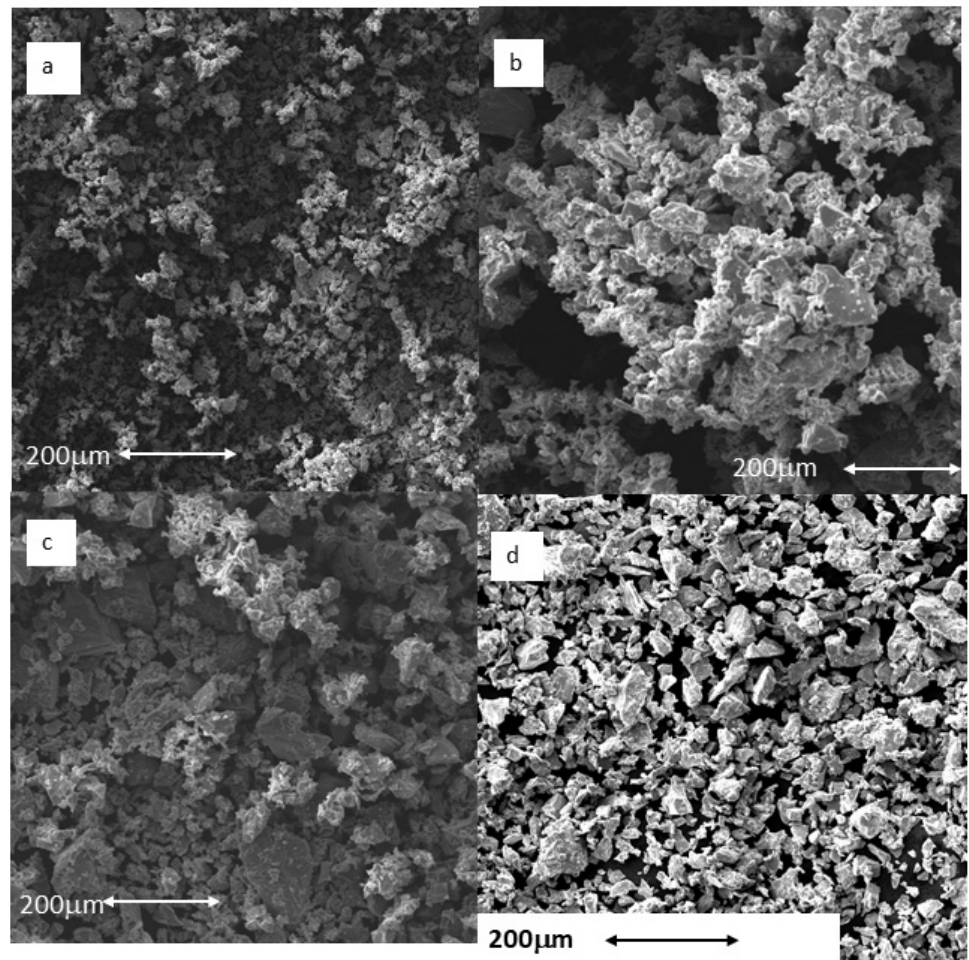
Figure 2. Particles observed by scanning electron microscopy: ( a ) Ti-5 μ m; ( b ) Ti-10 μ m; ( c ) Ti-15 μ m; ( d ) Ti-30 μ m. Scale bar = 200 μ m.